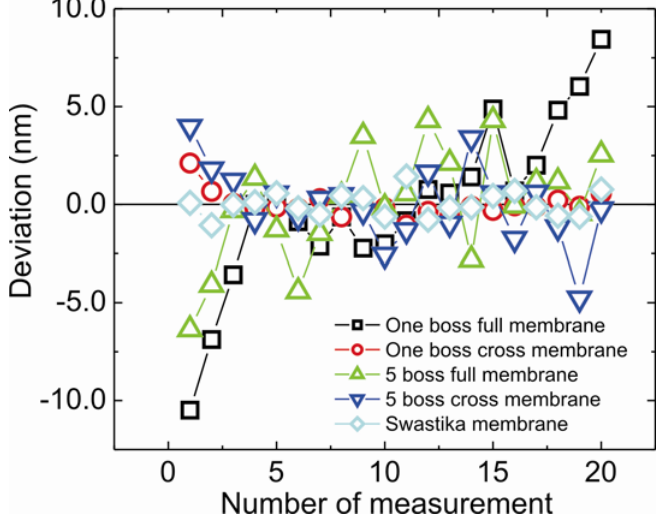
Figure 6 . Deviation vs number of measurements for single point measurement for all the membrane